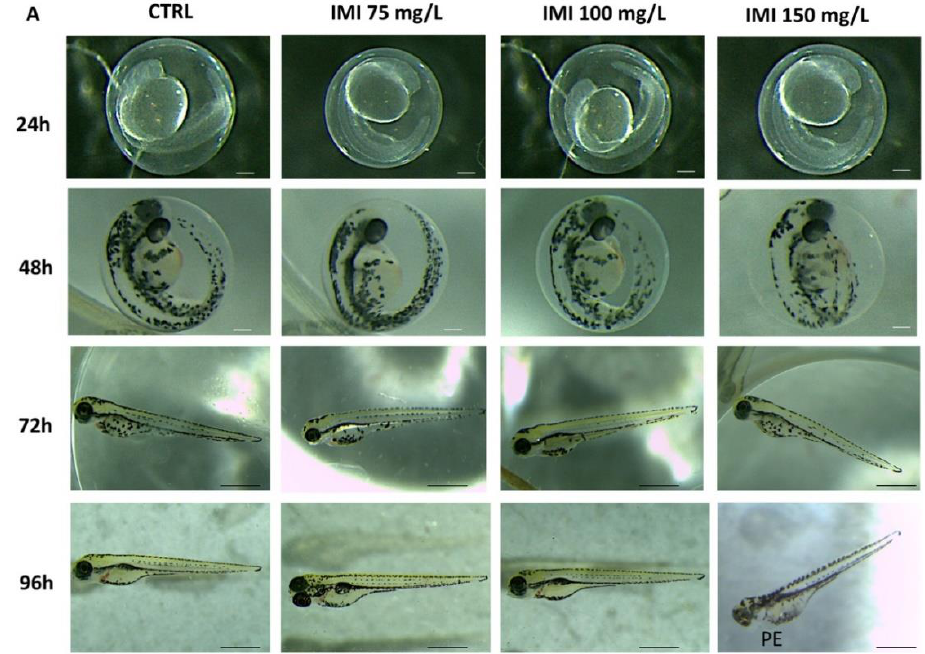
Figure 1. Morphological defections in zebrafish caused by different concentrations of IMI. PE—pericardial edema. Images were taken from the lateral view under a dissecting microscope (magnification 25 × ). Scale bar, 500 mm.